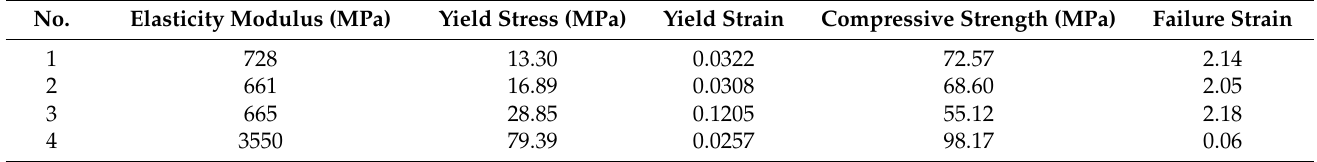
Table 2. Quasi-static compressive performance of RMs.